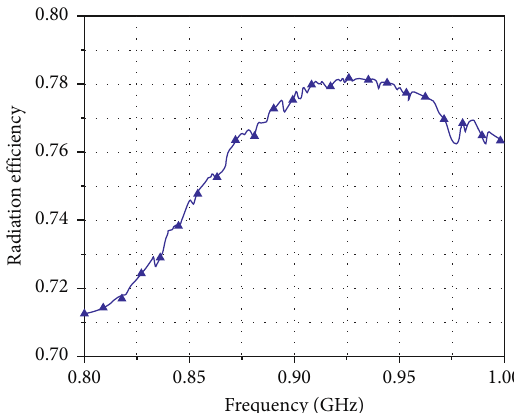
Figure 7: Measured radiation efficiency of the antenna. 11 | for the proposed